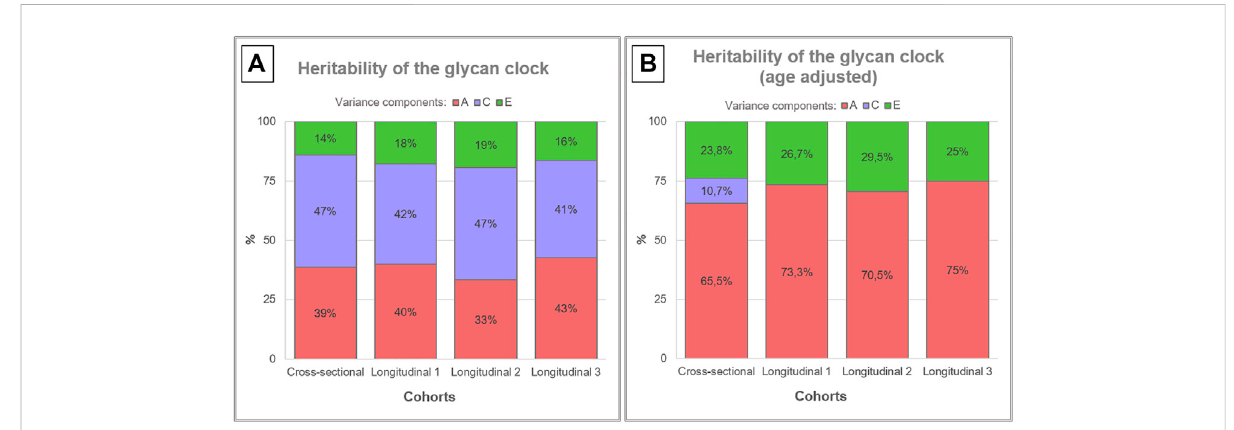
FIGURE 2 Heritabilityanalysisoftheglycanclock.Heritabilityoftheglycanclockwascalculatedforthecross-sectionalandlongitudinalcohortwiththree time points. (A) The best fi tting model was the full ACE model that includes additive genetic (A), shared environmental (C) and unique environmental (E) variance. (B) After correction for the age of the participants the full model for the longitudinal cohort was reduced to AE